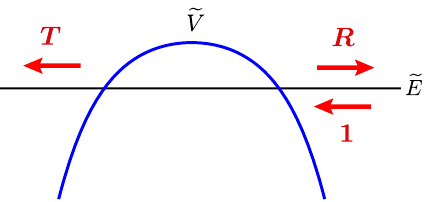
Figure 1. Scattering process by a potential wall. Resonant states are defined by the absence of the incoming wave. This occurs when 1/ R → 0 (or roughly | T | ∼ | R | (cid:29)